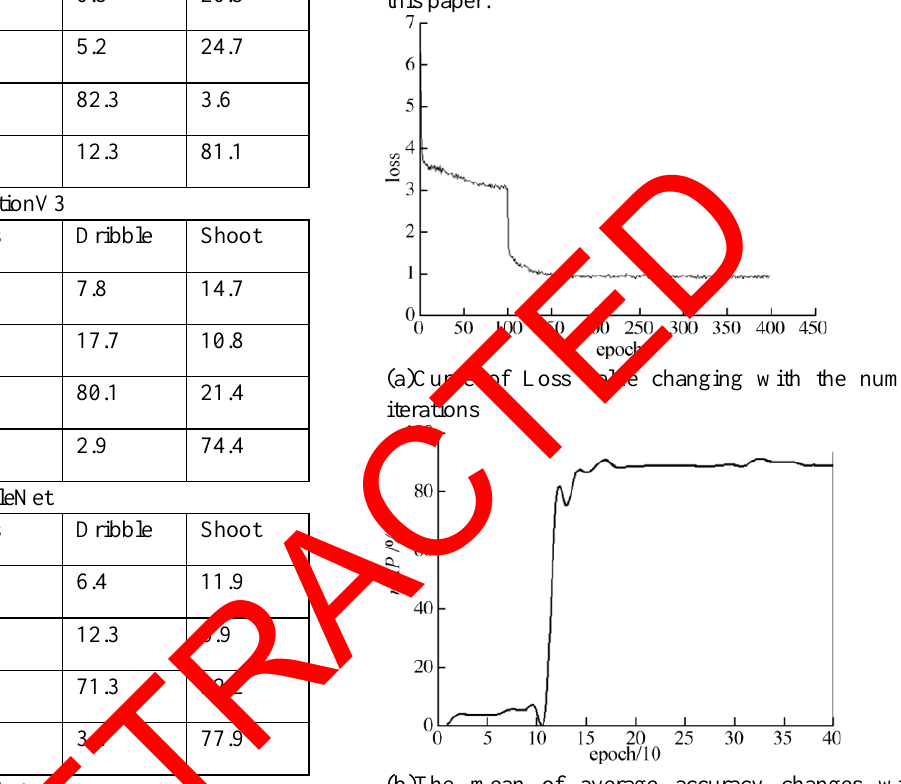
Figure 3. Confusion matrix of the five models